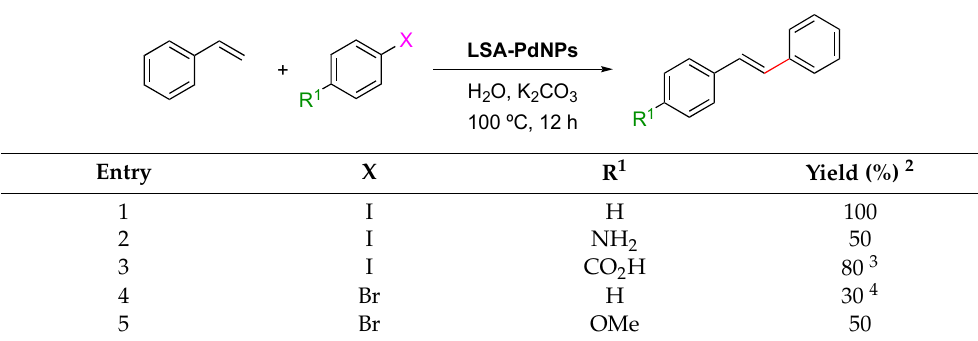
Table 8. LSA-PdNPs catalyzed the Heck reaction between aryl halides and styrene in aqueous alkaline conditions [71].